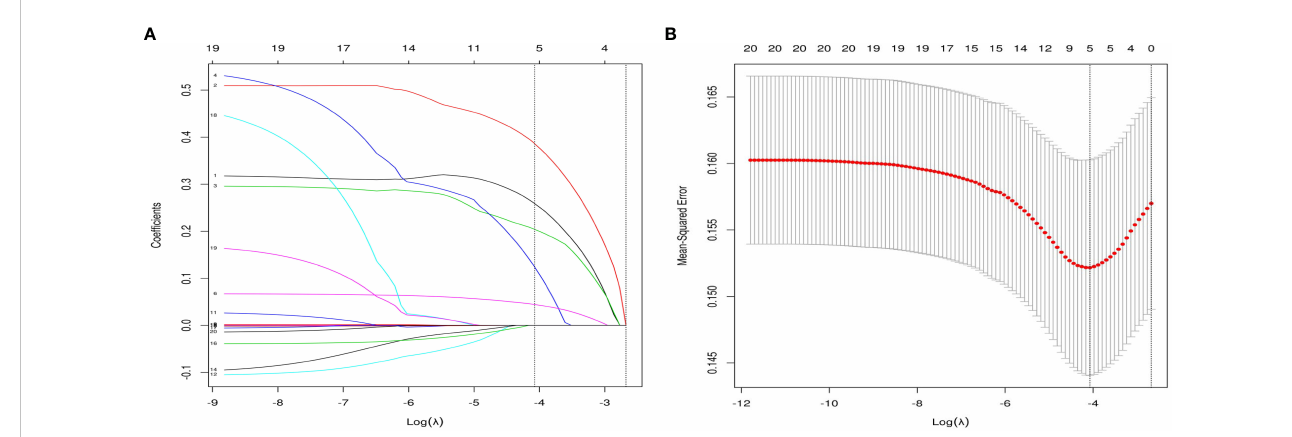
FIGURE 2 Variable selection by the LASSO binary logistic regression model. (A) eighteen variables with nonzero coef fi cients were selected by deriving the optimal lambda. (B) Following veri fi cation of the optimal parameter ( l ) in the LASSO model, the mean squared error changes with respect to the Log ( l ) value, and the vertical dotted line near Log ( l ) = − 4 is drawn based on 1 standard error criteria.